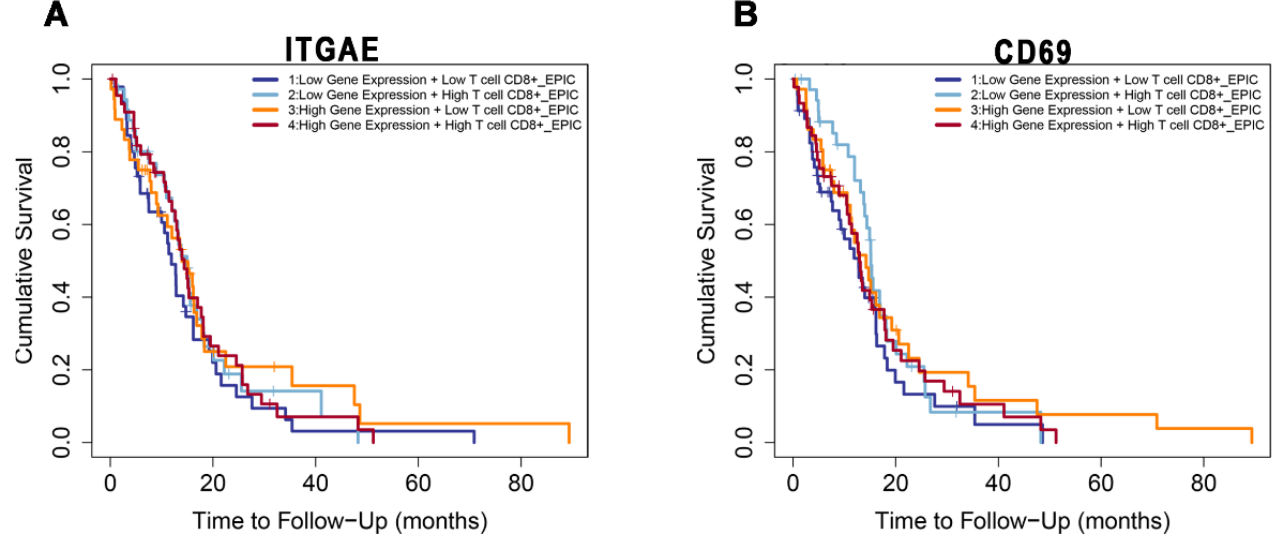
Figure 7. Kaplan-Meier curves from EPIC on a cohort of n = 153 patients with GBM and available follow-up. Shown is the correlation between ITGAE ( A ) and CD69 ( B ) gene expression and the cumulative survival of patients, according to CD8 + TIL abundance. ( A ), group 4 vs. group 3: HR = 1.4, p 0.201; group 2 vs. group 1: HR = 1.17, p 0.534. ( B ) group 2 vs. group 1: HR = 1.76, p = 0.049; group 4 vs. group 3: HR = 1.05, p = 0.851.